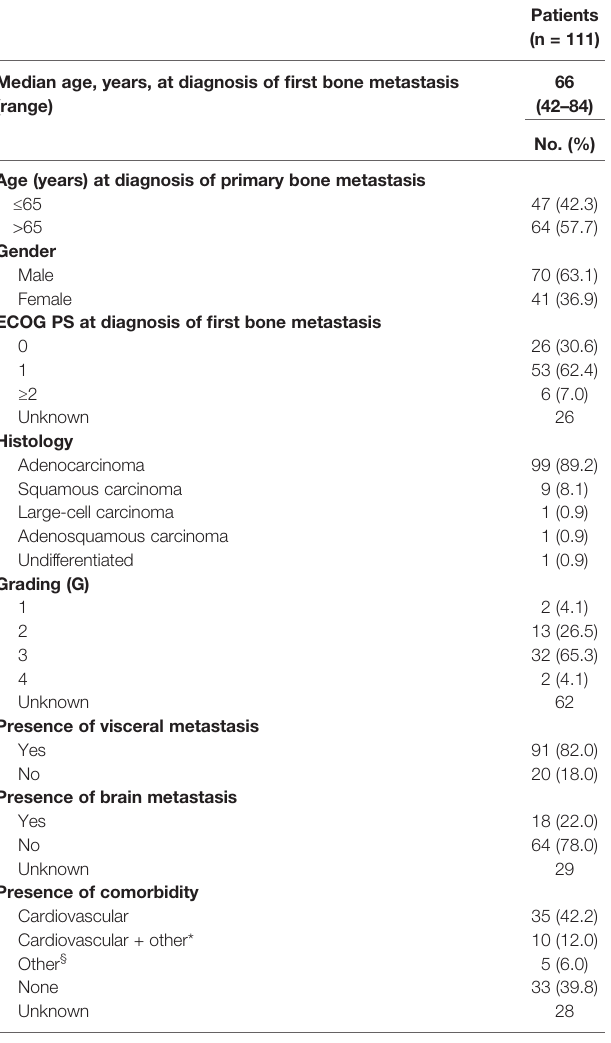
TABLE 2 | Biological characteristics of NSCLC patients (n = 111). Patients (n = 111)